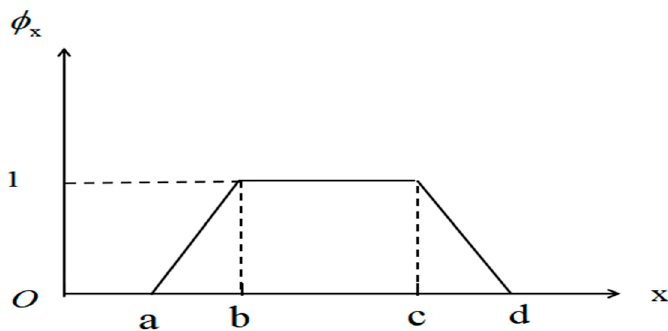
Figure 1. Trapezoidal distribution image.